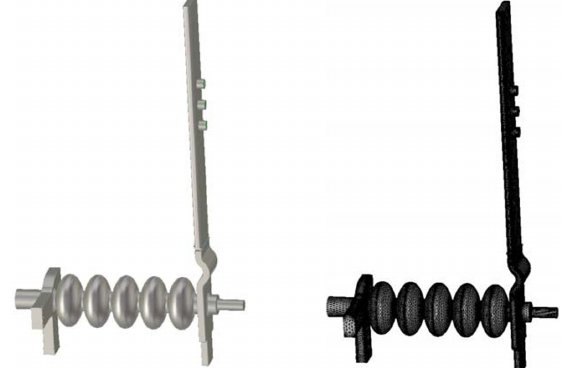
FIG. 18. The rf model (left) and mesh representation (right) for simulating a C50 cavity in a CM configuration.